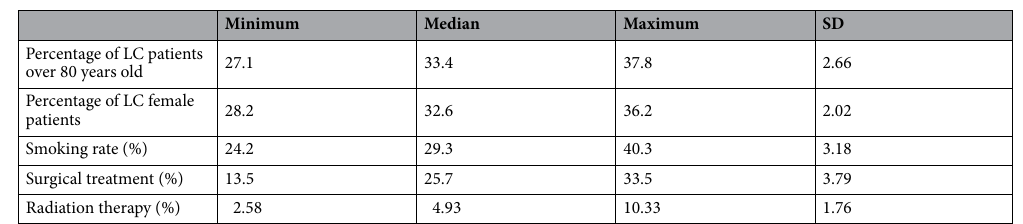
Table 3. Distribution of factors associated with EGFR gene mutations. LC Lung cancer, SD Standard deviation.